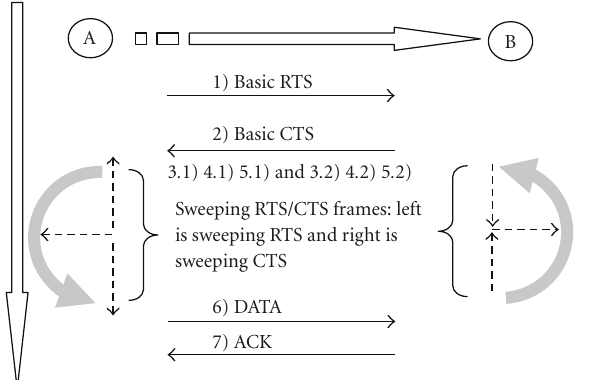
Figure 10: An example of DMAC-DACA reservation